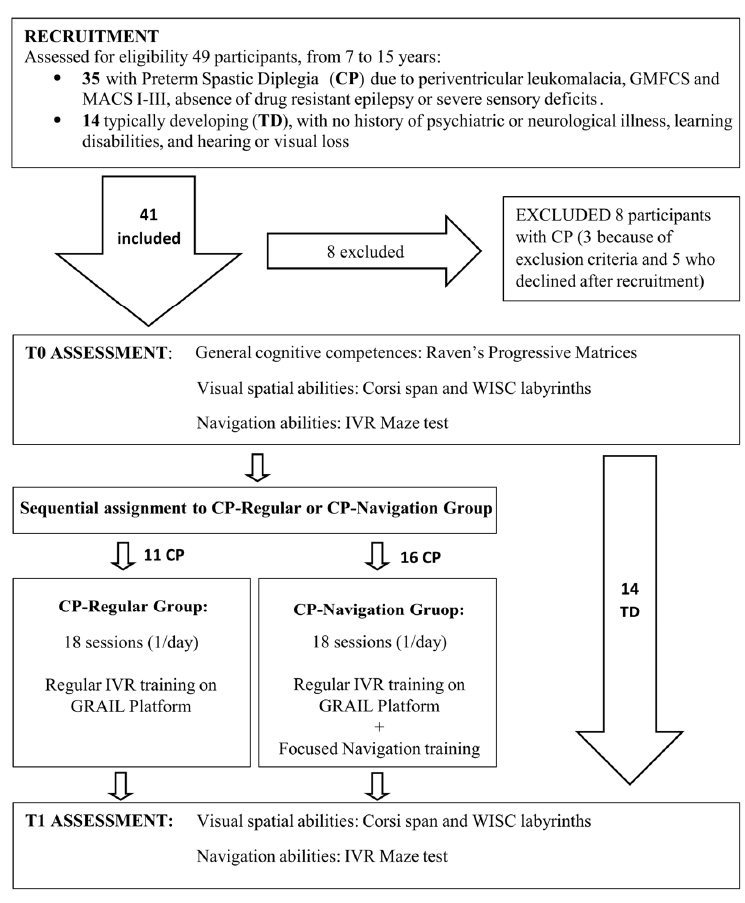
Figure 1. Design of the